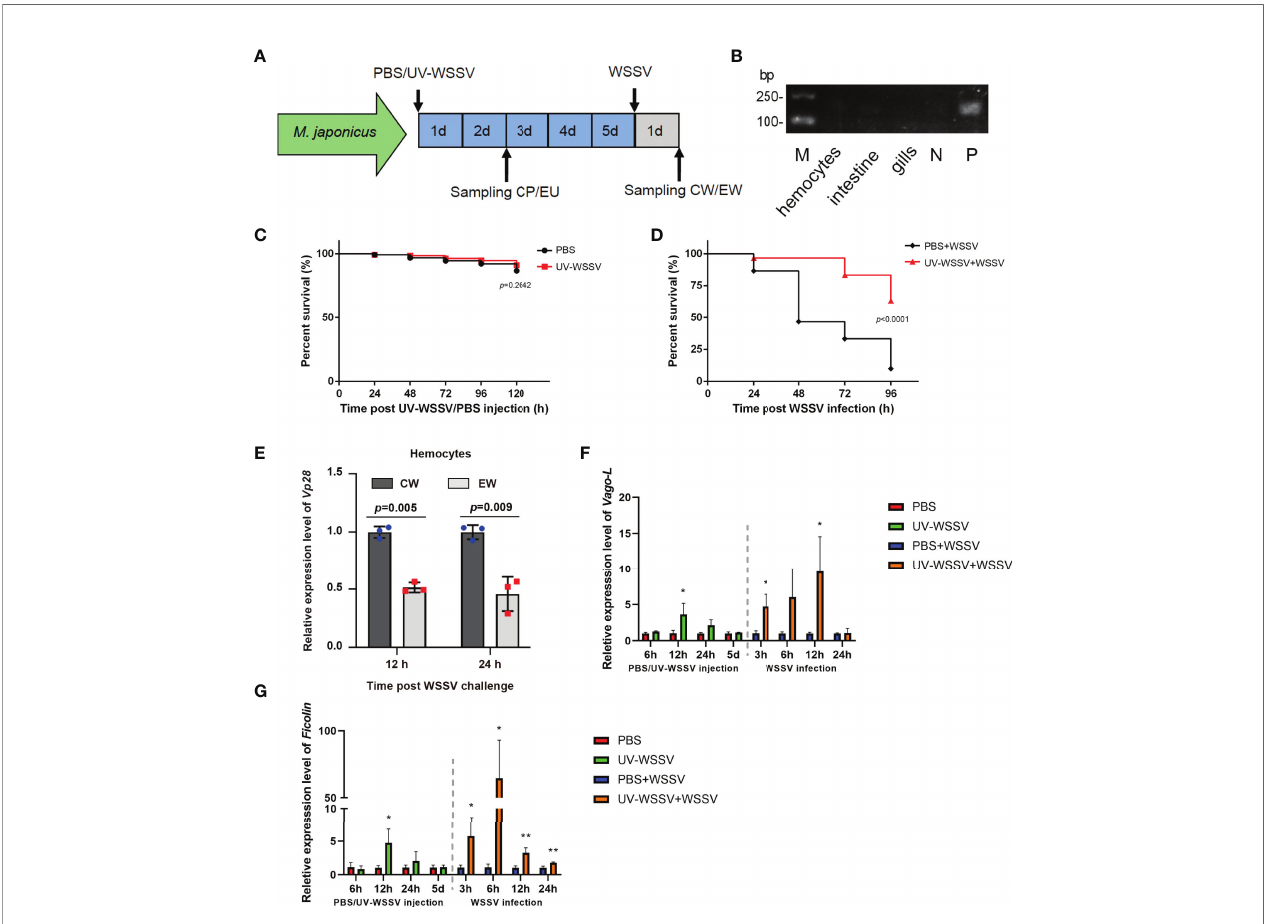
FIGURE 1 | Trained immunity model. (A) UV-WSSV-induced trained immunity in M. japonicus . UV-WSSV (50 m L, 5 × 10 5 copies) was injected into shrimp; the same volume of PBS was injected into controls. Five days after the fi rst injection (training), a second injection of WSSV was administered (50 m L, 5 × 10 5 copies). Hemolymph was collected at 48 h after the fi rst injection (CP, PBS-injected shrimp; EU, UV-WSSV-injected shrimp) and 24 h after the second one (CW, PBS- injected shrimp infected with WSSV; EW, UV-WSSV-injected shrimp infected with WSSV). (B) Vp28 expression in hemocytes, intestine and gills of shrimp analyzed by RT-PCR. N was negative control (ddH2O). P was positive control (WSSV). (C) Survival rate analysis of shrimp injected with UV-WSSV; controls were injected with an equal volume of sterile PBS. (D) Survival rate of shrimp, which was analyzed using the log-rank (Mantel – Cox) test. Normal shrimp were divided into two groups, and the experimental group was fi rst trained with UV-WSSV, and then live WSSV was injected after 5 days. In case of the control group, an equal volume of sterile PBS was fi rst injected, and then the same amount of WSSV was administered. (E) WSSV replication was analyzed using Vp28 as an indicator in hemocytes of control and UV-WSSV trained shrimp at 12 and 24 h post WSSV infection (the second infection). The shrimp injected with a corresponding amount of PBS in training period and then infected with WSSV were used as controls. (F, G) The expression patterns of Vago-L (F) and Ficolin (G) in hemocytes of shrimp in the UV-WSSV trained immunity model. Student ’ s t test was used for statistical analysis, and p < 0.05 was considered to demonstrate statistically signi fi cant differences. * p < 0.05, ** p <